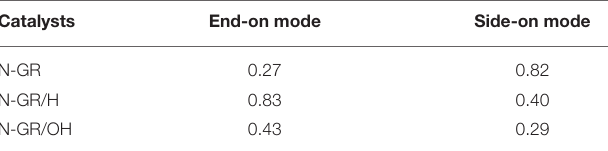
TABLE 1 | The adsorption energy of O 2 on different doped GRs by end-on mode and side-on mode. (Unit/eV).